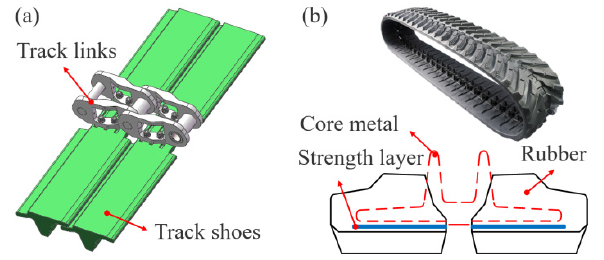
Figure 2. Structure of tracks: ( a ) steel tracks and ( b ) rubber tracks (Yachoo). Table 2. Comparison between the two types of tracks. Type Advantages and Type Products and Application